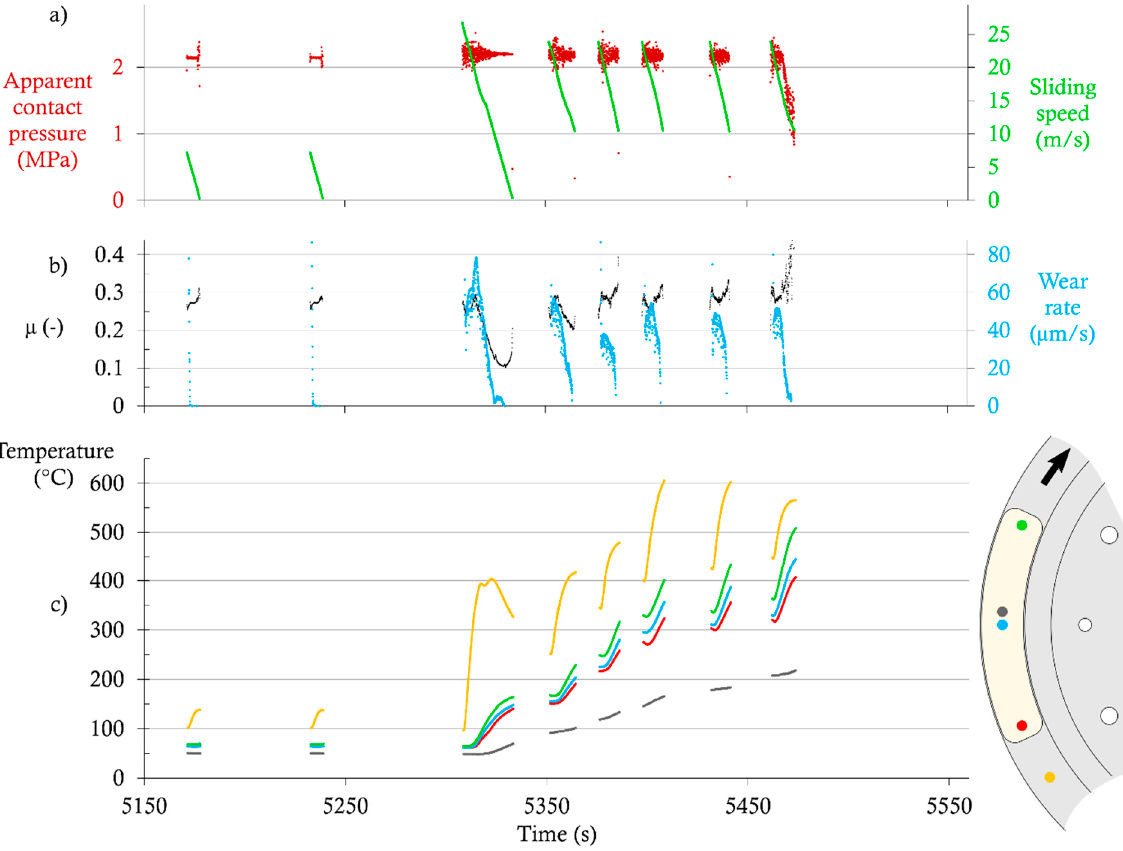
Figure 8. Extract of test data for the NAO-GCI configuration: ( a ) Apparent contact pressure and sliding speed; ( b ) coefficient of friction (CoF) and wear rate; ( c ) disc and pad temperatures.